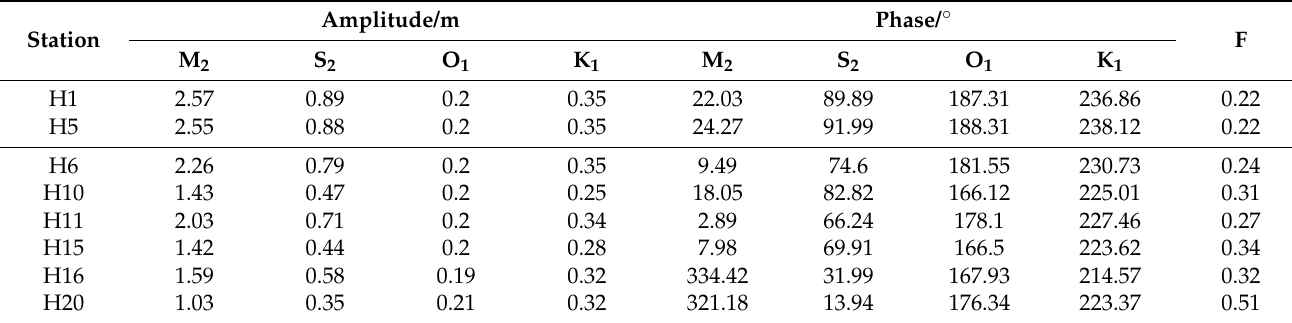
Figure 6. SLR-induced tidal range changes under ( a ) 0.44 m SLR, ( b ) 0.56 m SLR, ( c ) 0.68 m SLR and ( d ) 0.77 m SLR, which are calculated by the tidal ranges in different sea level scenarios minus that in the RSLR. Table 4. The amplitude and phase of the main tidal constituent within the flood season variations at eight tidal gauges (see Figure 4 for the